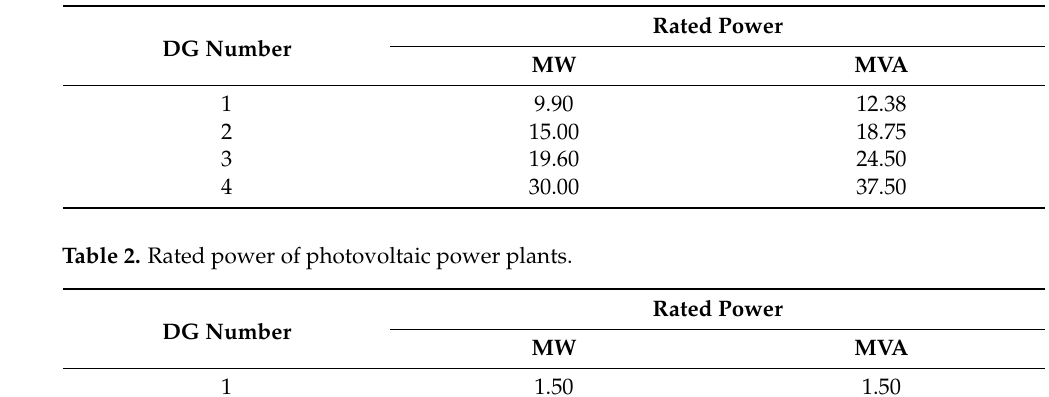
Table 1. Rated power of biomass power plants.